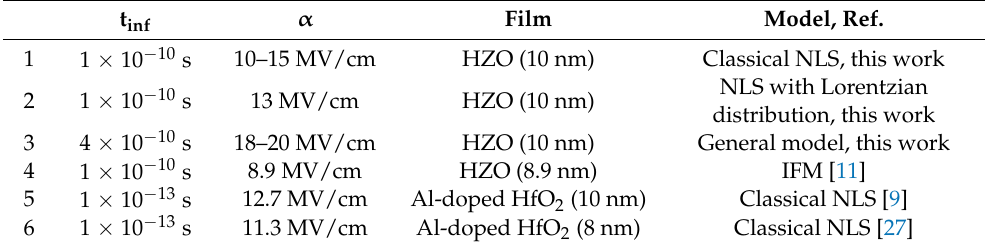
Table 1. Switching kinetics parameters for HfO 2 -based capacitors obtained by different models.